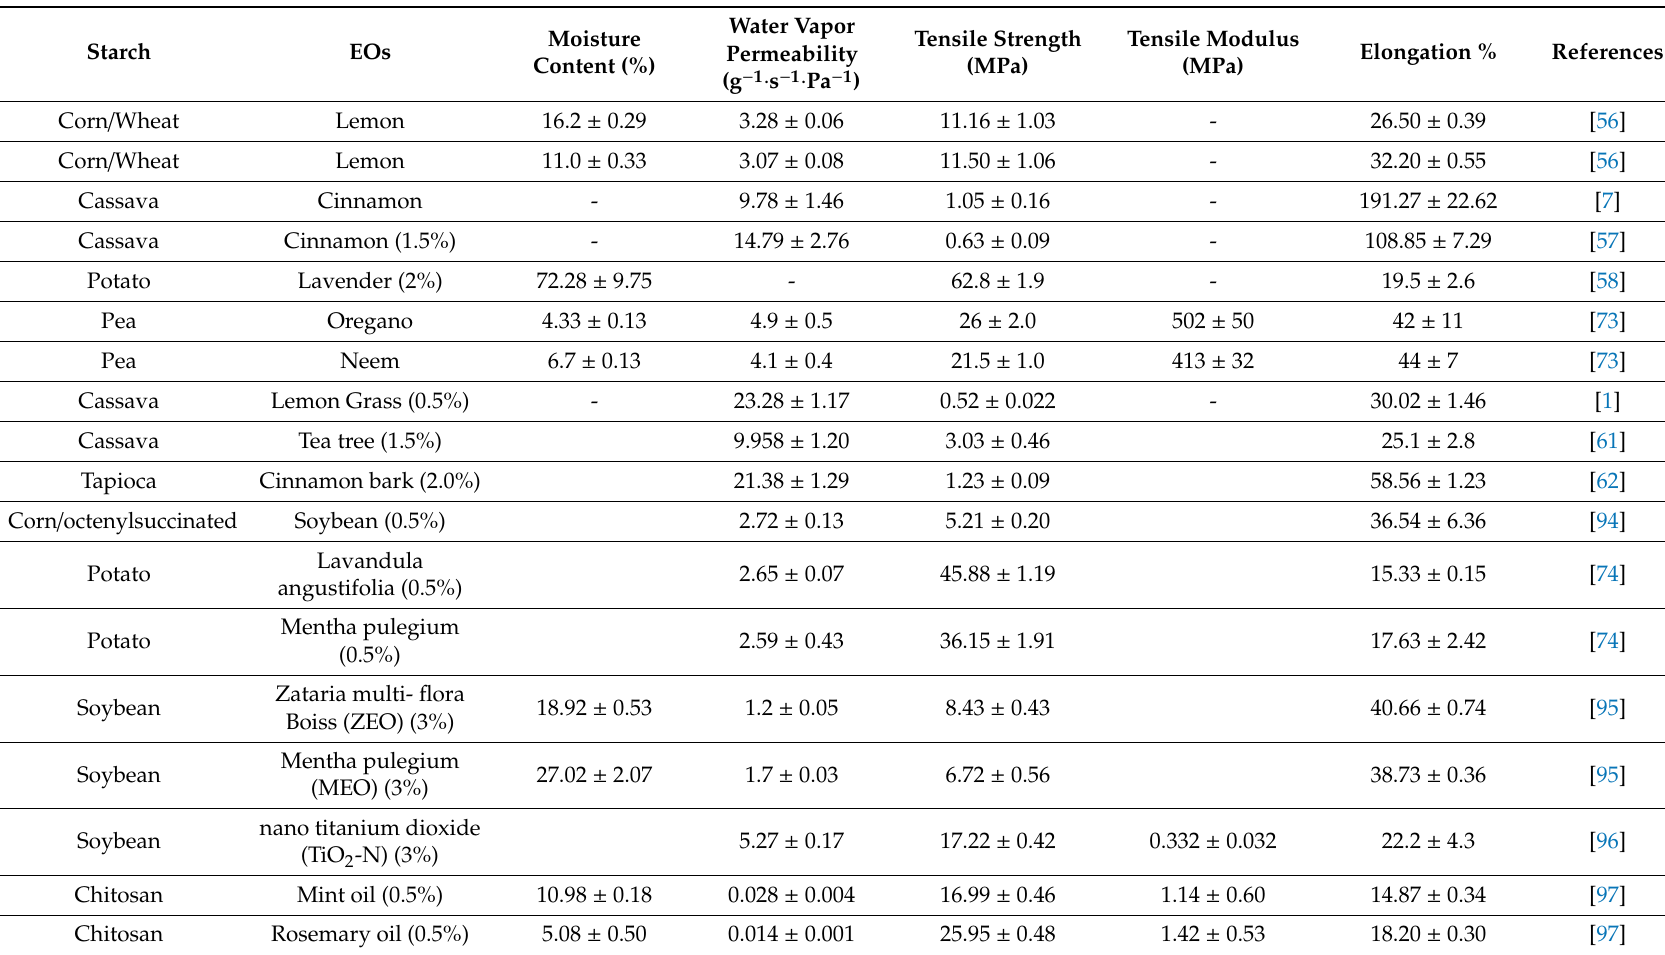
Table 3. Moisture content, water vapor permeability (WVP), Tensile strength (MPa) and elongation at break (%) of anti-microbacterial agent reinforced starch biopolymer.